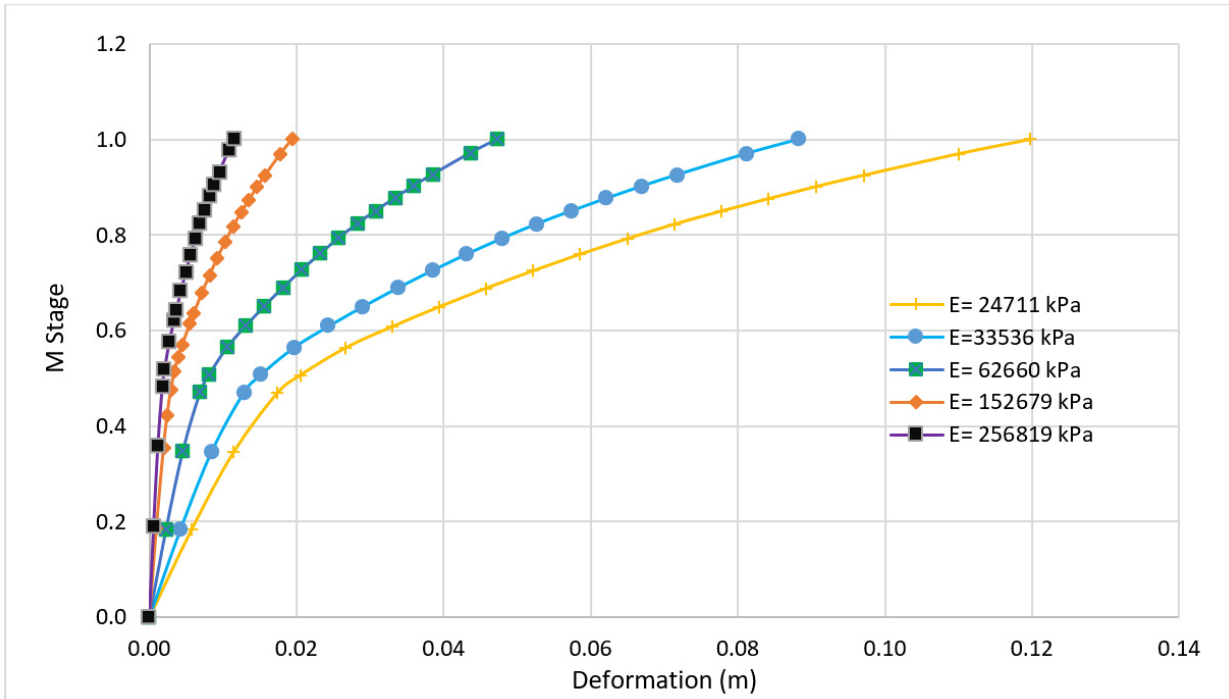
Figure 8. Effect of the modulus of elasticity on the deformation properties.